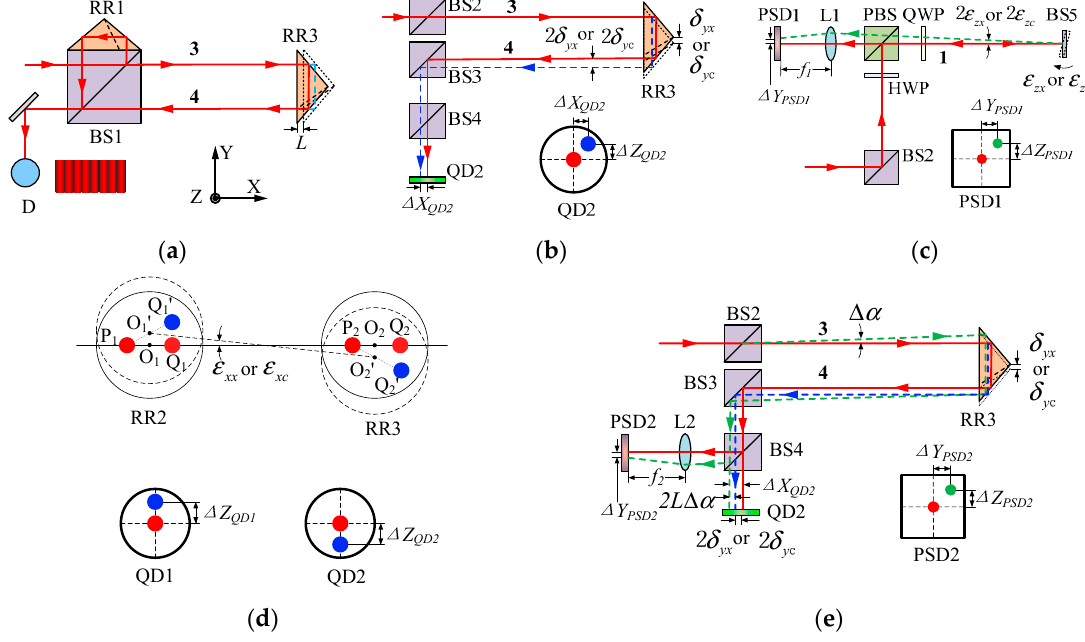
Figure 3. Schematic diagram for measuring each single geometric motion error: ( a ) Linear error in X-axis direction; ( b ) Linear errors in Y- and Z-axis directions; ( c ) Angular errors around Y- and Z-axis; ( d ) Angular error around X-axis; ( e ) Laser beam drift compensation.